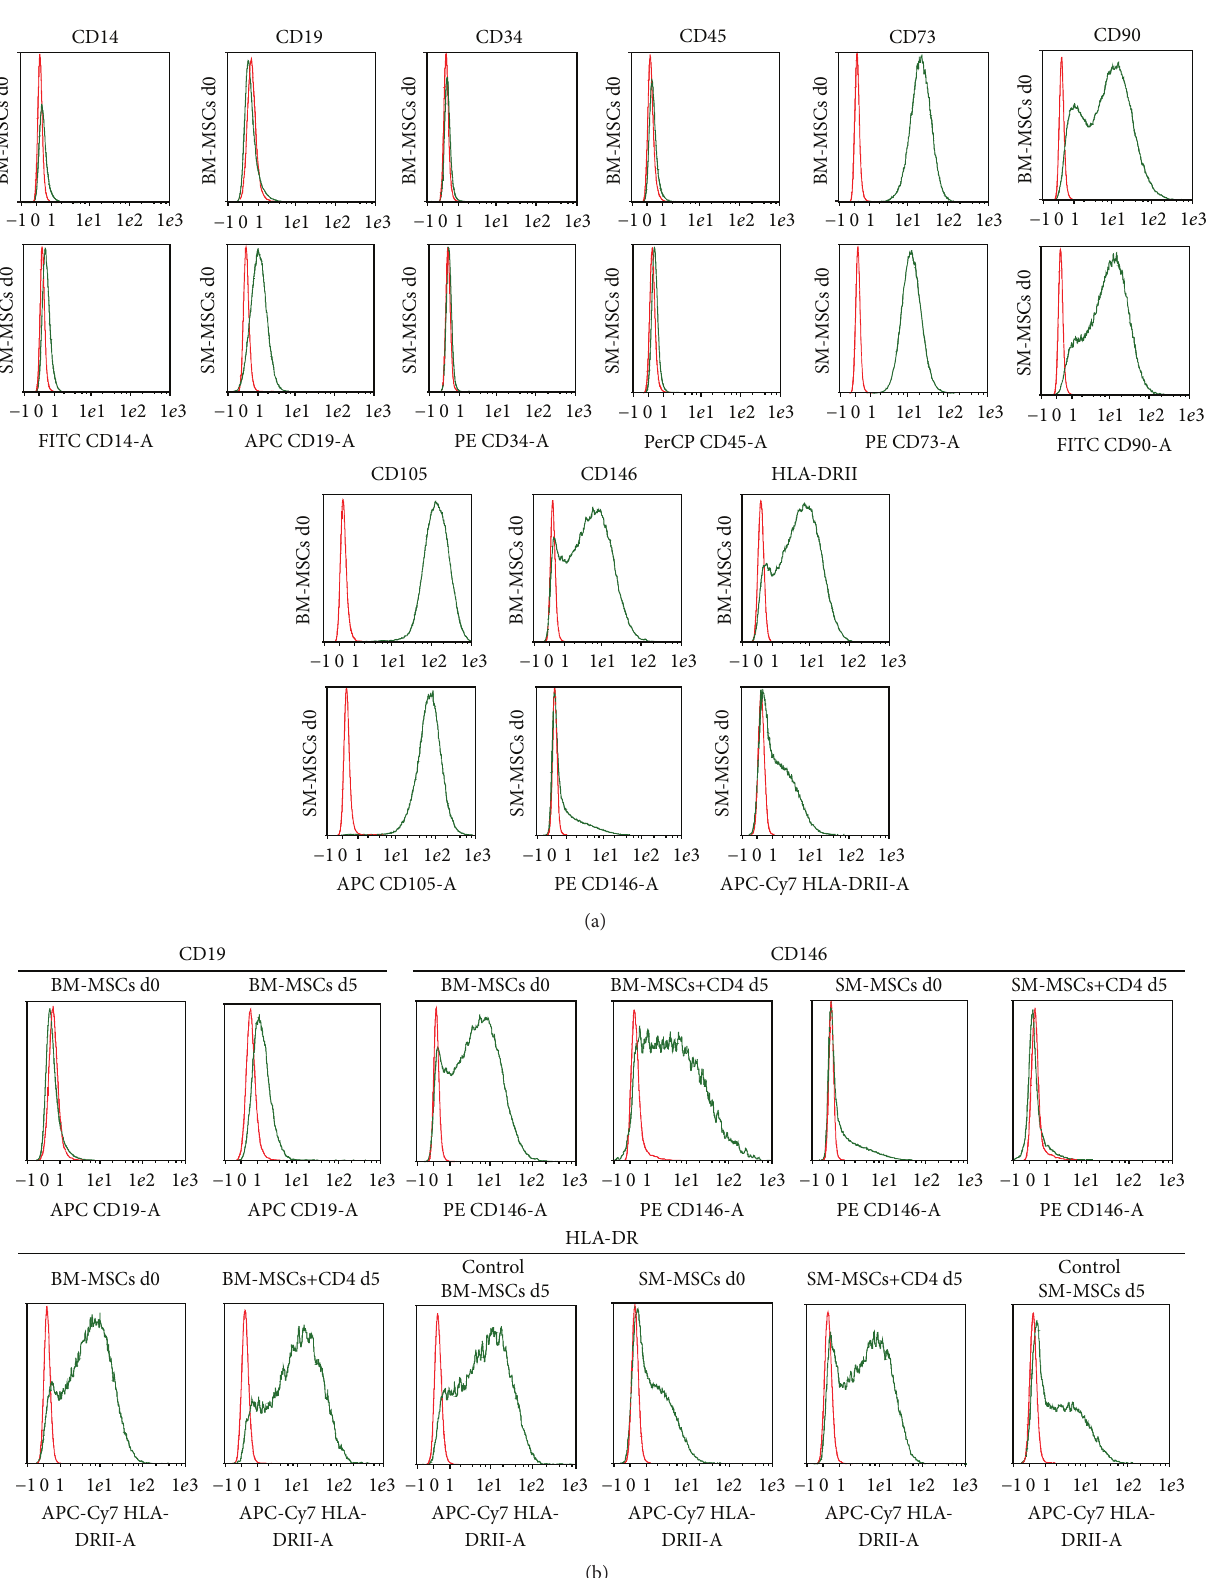
Figure 2: Surface marker expression on SM-MSCs and BM-MSCs. (a) Representative histograms of surface marker expression on SM-MSCs and BM-MSCs as detected by flow cytometry before coculture or monoculture. Red: background fluorescence; green: surface marker. (b) Marked differences between the groups were observed for CD19, CD146, and HLA-DR, as shown by representative histograms. See Table 1 for means and standard